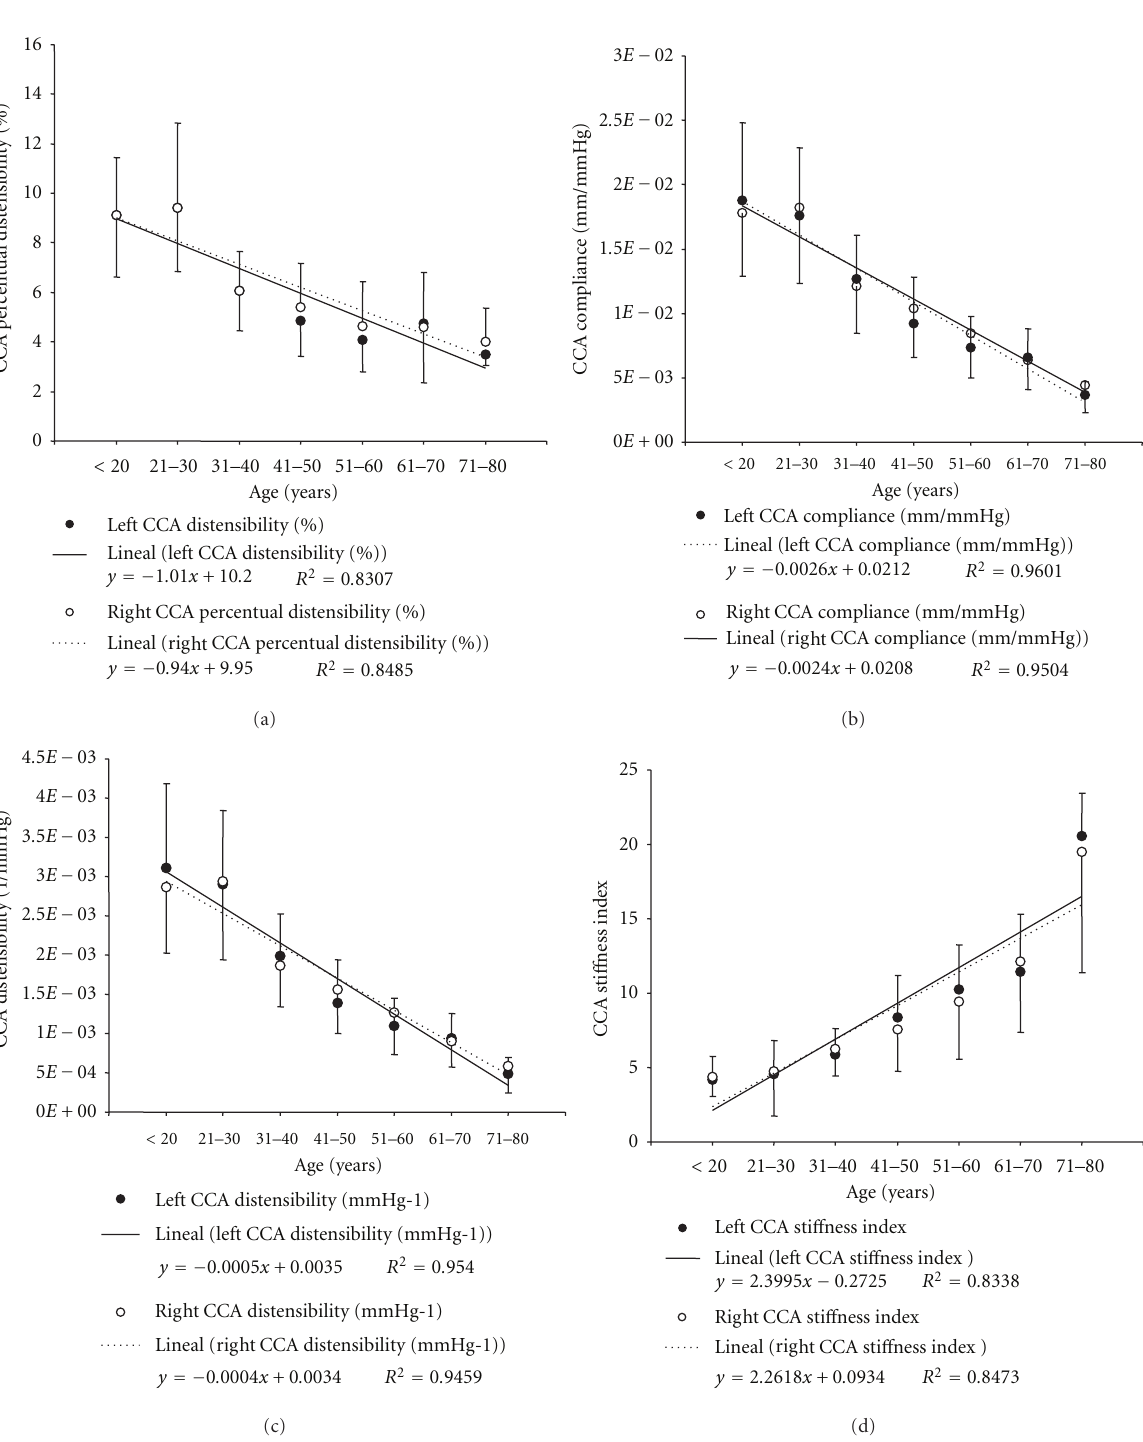
Figure 5: Common carotid artery (CCA) local sti ff ness parameters. CCA percentual or fractional pulsatility (a), compliance (b), distensibility (c), and Beta or sti ff ness index (d) age- (decade-) related